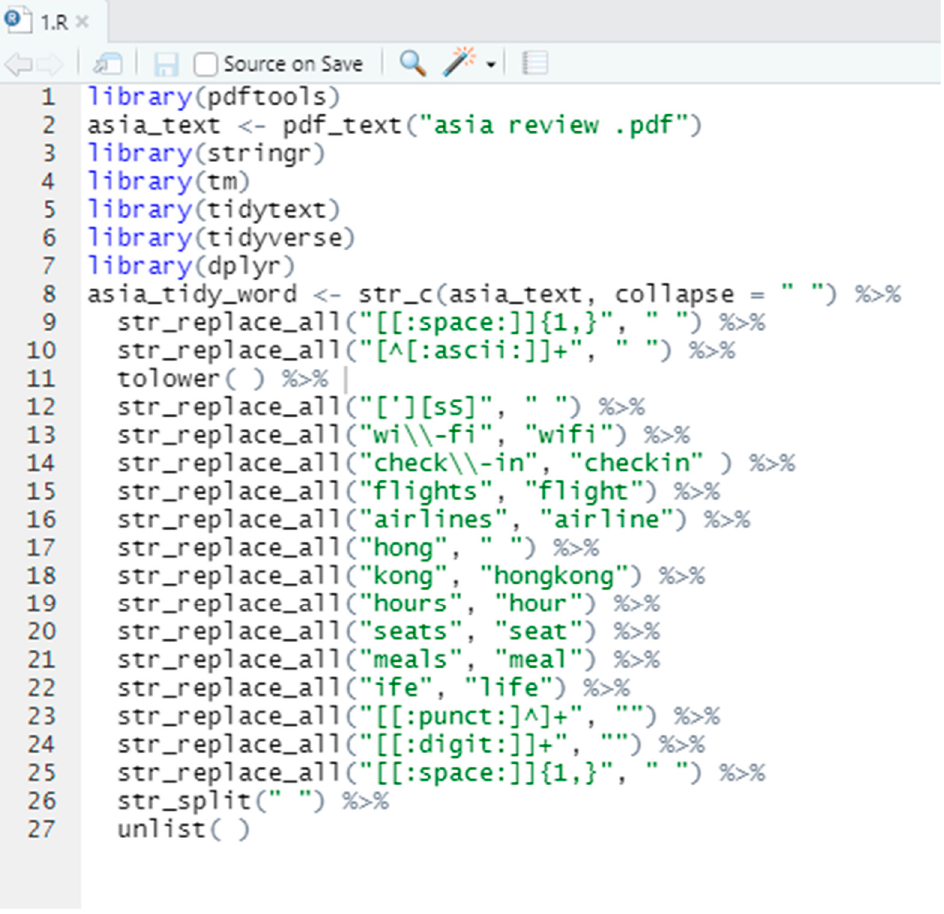
Figure 2. The morpheme analysis function commands.